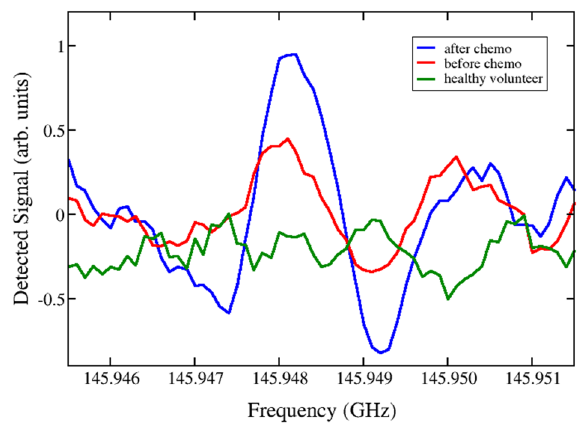
Figure 1. Experimental detection of the absorption spectral line of isobutyronitrile (i-C3H7CN) near the frequency f c = 145.9481 GHz, measured in the sample of patient 2 before (solid, red) and after chemotherapy (solid, blue), together with the corresponding reference measurement for healthy volunteer 1 (dashed, green). There are two close lines near this frequency at f − = 145.9478961 GHz, characterized in the databases 31,32 by Lg